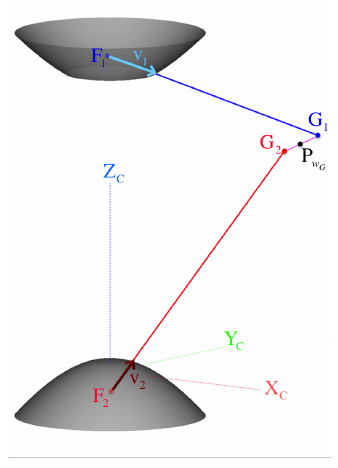
Figure 16. The more realistic case of skew back-projection rays ( v 1 , v 2 ) approximates the triangulated point P w by getting the midpoint P w on the common perpendicular line segment G 1 G 2 : λ 1 ⊥ 2 ˆv 1 ⊥ 2 . G Note that the visualized skew rays were formed from a pixel correspondence pair [ I ] ( m 1 , m 2 ) and by offsetting the coordinate u 2 by 15